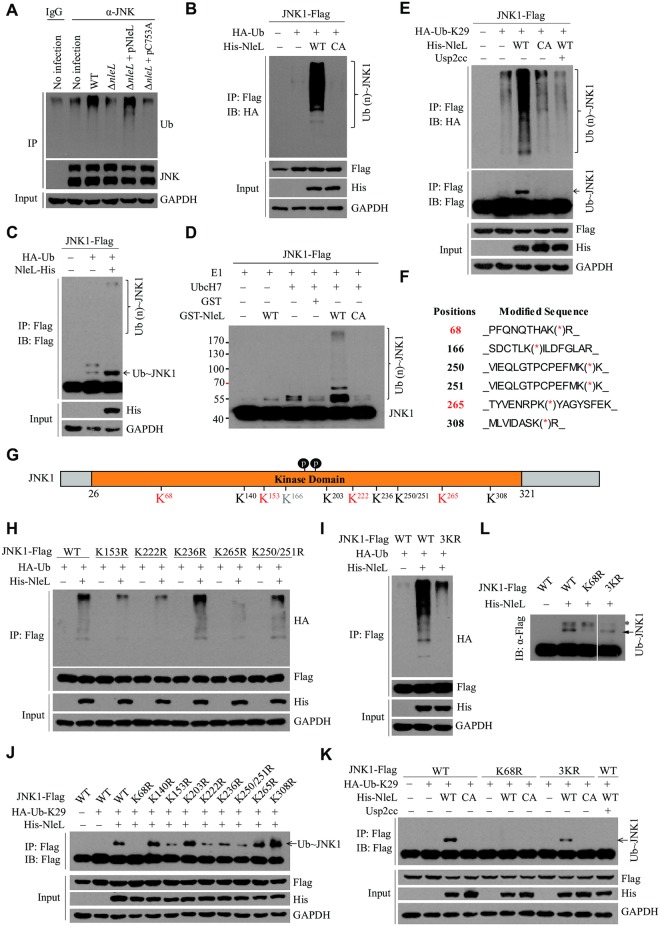
NleL ubiquitylates human JNK1.(A) NleL ubiquitylated endogenous JNK during EHEC O157:H7 infection. HEK293T cells were infected with EHEC strains with MOI of 100:1. 2.5 h after infection, cells were washed with PBS and cultured in the fresh DMEM medium for 2 h. Cells were lysed and subjected to IP with anti-JNK antibody and IB with anti-Ub antibody. (B) NleL ubiquitylated JNK1 in vivo. HEK293T cells were co-transfected with plasmids encoding HA-tagged Ub, Flag-tagged JNK1, His6-tagged wild-type NleL or its C753A mutant. Flag-tagged JNK1 was immunoprecipitated with anti-Flag M2 beads in denaturing RIPA buffer, followed by IB analyses with anti-HA antibody. (C) NleL induced mono- and poly-ubiquitylation of JNK1 in vivo. HEK293T cells were co-transfected with plasmids encoding HA-tagged Ub, Flag-tagged JNK1 and His6-tagged NleL. Flag-tagged JNK1 was immunoprecipitated with anti-Flag beads in denaturing RIPA buffer, followed by immunoblotting with anti-Flag antibody. (D) NleL ubiquitylated JNK1 in vitro. Flag-tagged JNK1 was expressed in HEK293T cells and purified with anti-Flag M2 affinity beads, and were subjected to in vitro ubiquitylation reaction mixture with indicated components. After 60 min incubation, the reactions were stopped and subjected to IB analysis with anti-Flag antibody. (E) NleL promoted mono- and poly-ubiquitylation of JNK1 with K29-Ub. HEK293T cells were co-transfected with plasmids encoding HA-tagged Lys 29 only Ub mutant (HA-K29-Ub), Flag-tagged JNK1, His6-tagged wild-type NleL or its C753A mutant. After immunoprecipitation, immunoblotting analyses with indicated antibodies were performed. Usp2cc, the catalytical core of human deubiquitylating enzyme USP2. (F) Mapping the sites for NleL-mediated ubiquitylation of JNK1 through mass spectrometry (MS) analyses. The immunoprecipitated JNK1 from HEK293T cells expressing NleL was subjected to MS analysis to determine the potential sites for NleL-mediated ubiquitylation. (G) A schematic view of the potential ubiquitylation sites of JNK1. The residues K68, K153, K222, and K265 were highlighted in red color to indicate the major ubiquitylation sites. (H) NleL promoted poly-Ub chains on JNK1 at multiple sites. HEK293T cells were transfected with His6-tagged NleL and Flag-tagged wild-type JNK1 or the mutants with Lys-to-Arg substitution at indicated sites. (I) NleL-mediated poly-ubiquitylation of JNK1 was almost abolished by simultaneous Lys-to-Arg substitutions at three major ubiquitylation sites (K153R/ K222R/K265R, 3KR). (J) Mapping the major site(s) for NleL-induced mono-ubiquitylation on JNK1. Flag-tagged wild-type JNK1 or its mutants bearing K-to-R substitution at each potential ubiquitylation site was individually transfected to HEK293T cells with His-NleL and HA-Ub-K29. (K) Lys-to-Arg substitution at Lys 68 (K68R) of JNK1 abolished NleL-induced mono-ubiquitylation of JNK1 in mammalian cells. (L) K68R of JNK1 abolished NleL-mediated JNK1 mono-ubiquitylation in vitro. Flag-tagged wild-type JNK1 or the indicated mutants (K68R and 3KR) were separately expressed in HEK293T cells and purified with anti-Flag M2 affinity beads. Purified JNK1 protein or its mutants was subjected to in vitro ubiquitylation reaction mixture at 37°C for 1h, followed by immunoblotting with indicated antibodies. All blots were representative of at least three independent experiments.